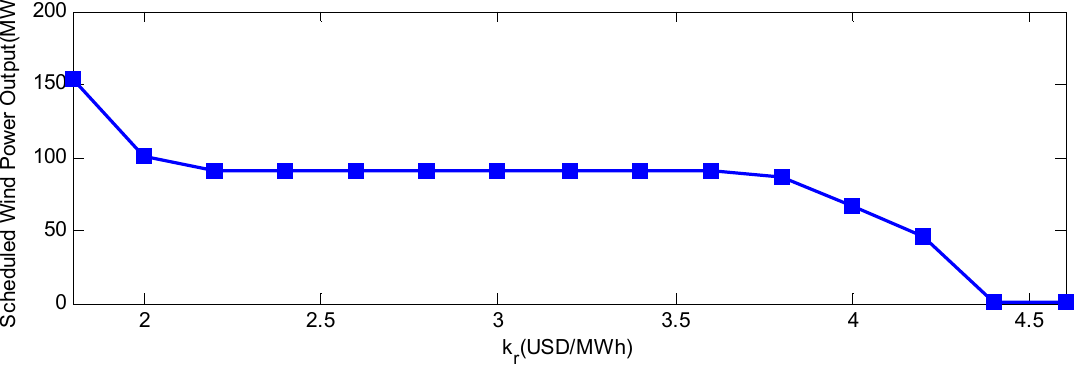
Figure 6. The scheduled wind power output as a function of up reserve cost coefficient.